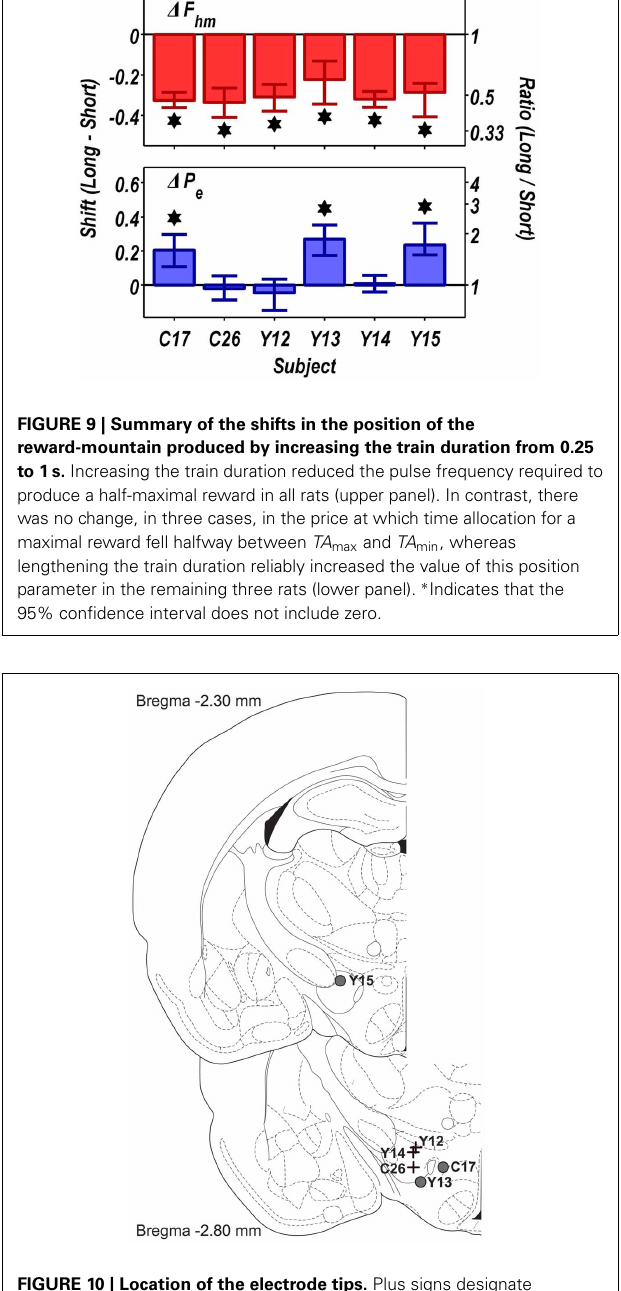
FIGURE 10 | Location of the electrode tips. Plus signs designate placements for which the reward mountain did not shift along the price axis, whereas filled circles designate placements for which rightward shifts were observed when the train duration was